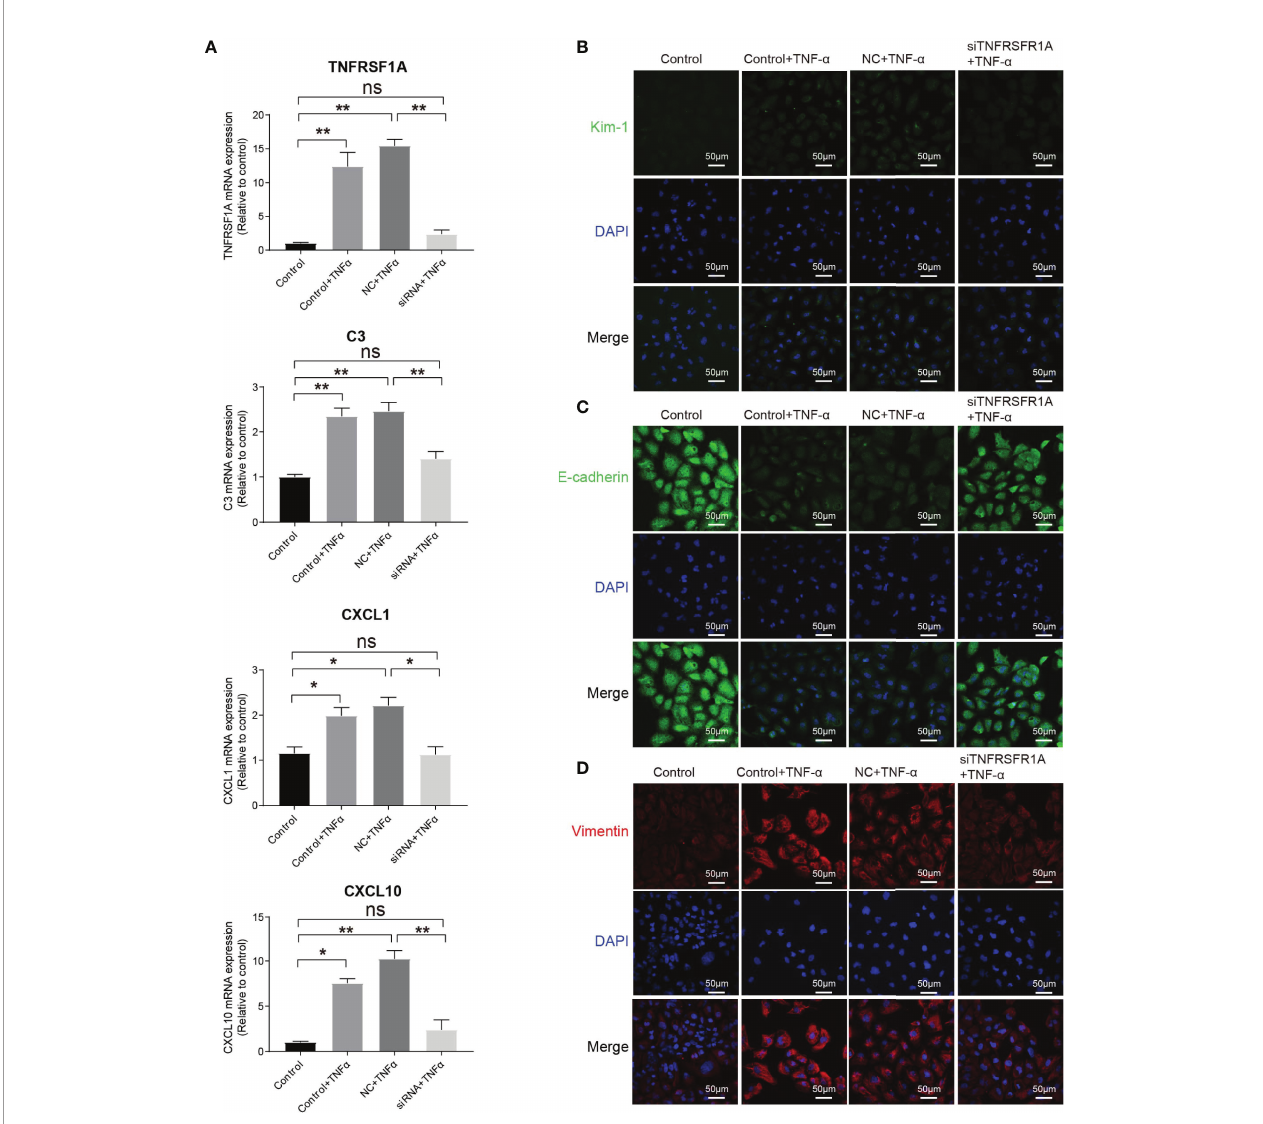
FIGURE 6 | Role of TNF/TNFRSF1A in AKI. (A) Expression level of TNFRSF1A and in fl ammatory signatures C3, CXCL1 and CXCL10 when receiving TNF- a stimulation or not. (B – D) Immunostaining showing the expression of injury marker Kim-1 (B) , PTC marker (E-cadherin, C) and trans-differentiation marker (Vimentin, D) when receiving TNF- a stimulation or not. Data are performed as means ± SD for three independent experiments. One-way ANOVA with Turkey post hoc tests was used for three or more group comparisons. *p<0.05, **p<0.01. ns, Not Statistically Signi fi